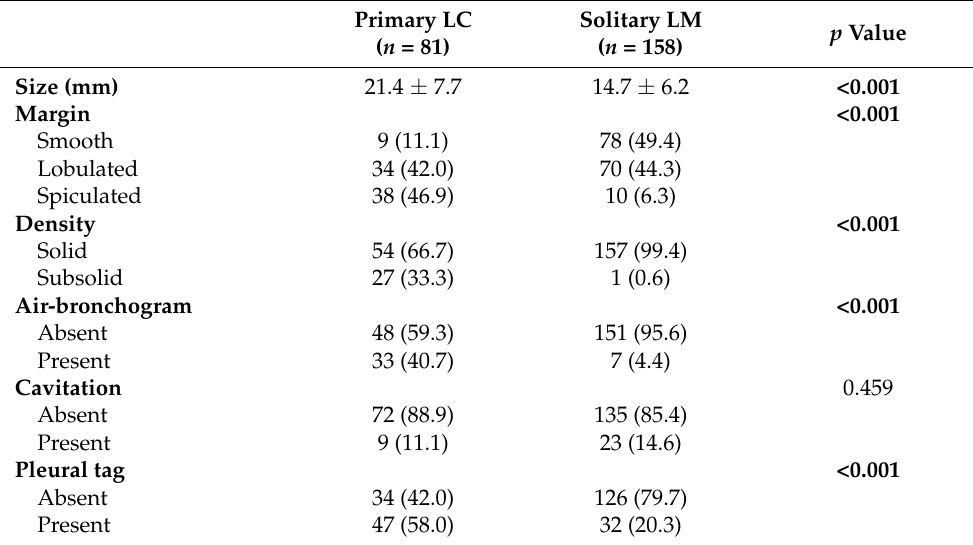
Table 2. Semantic CT imaging features of solitary pulmonary nodules.